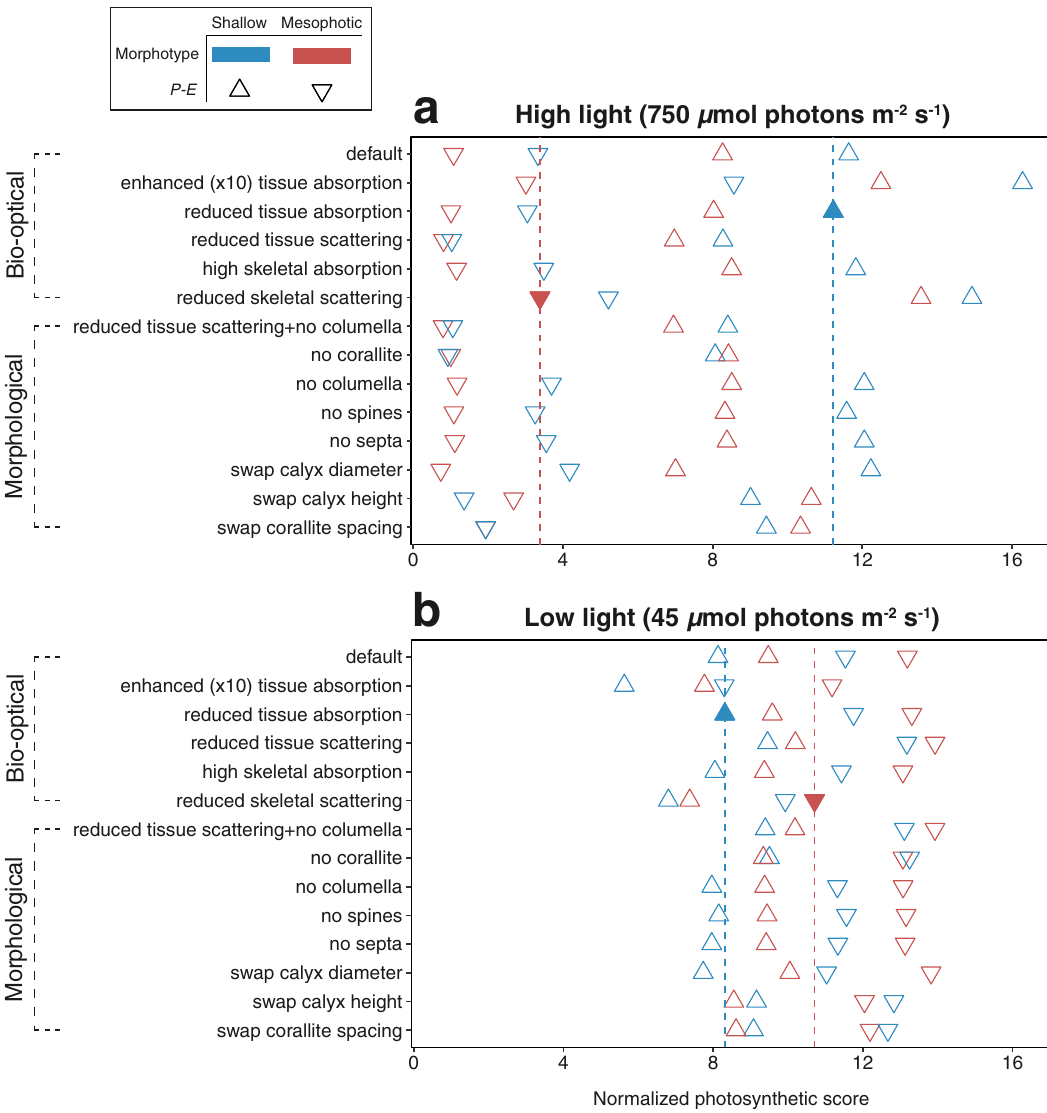
Fig. 6 Photosynthetic scores normalized per tissue pixel of different bio-optical and morphological simulation scenarios. Photosynthetic scores normalized per tissue pixel of different bio-optical and morphological simulation scenarios under a high-light (equivalent to 5m; 750 µ mol photons m − 2 s − 1 ) and b low-light (equivalent to 50m; 45 µ molphotonsm − 2 s − 1 ) conditions. Color denotes the morphotype (shallow: blue; mesophotic: red) and the ambient photosynthetic performance ( P-E ) is represented by shape (shallow: triangle point up; mesophotic: triangle point down). Filled triangles and dashed vertical lines represent the scores for settings as found in nature for shallow and mesophotic